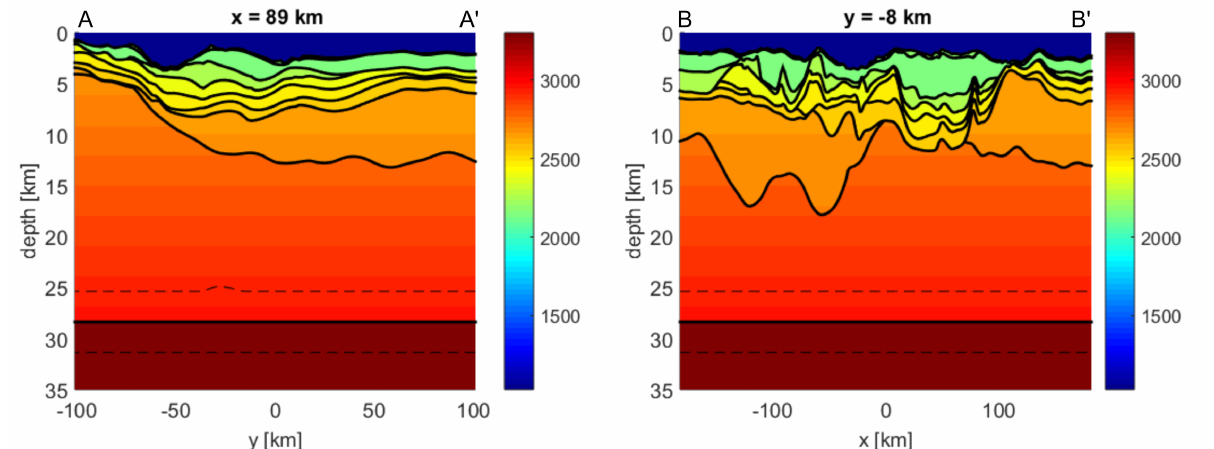
Figure 3. Example of two profiles (AA’ and BB’ in Figure 1) for the two-layer problem inversion. Solid black lines represent discontinuity between different geological units, dashed lines represent uncertainty, colours represent density in kg/m 3 .